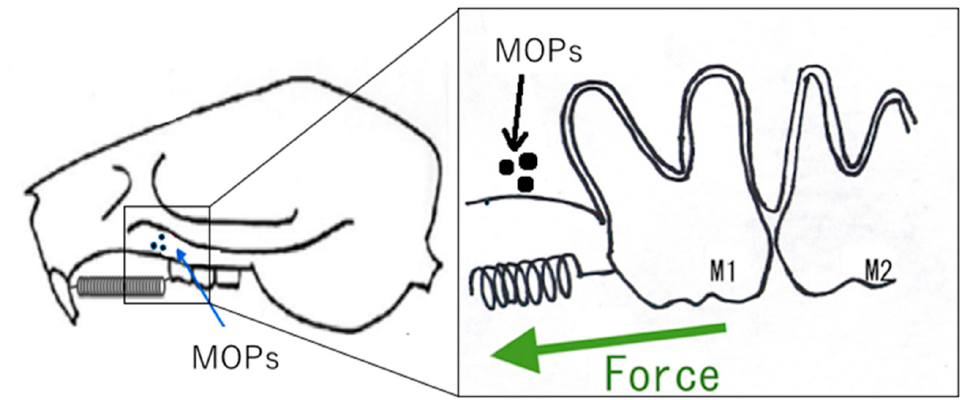
Figure 7. The schema of AOTM in rat experimental tooth movement model by MOPs [132]. Abbrevi- ations: AOTM = accelerating orthodontic tooth movement, MOPs = micro-osteoperforations.